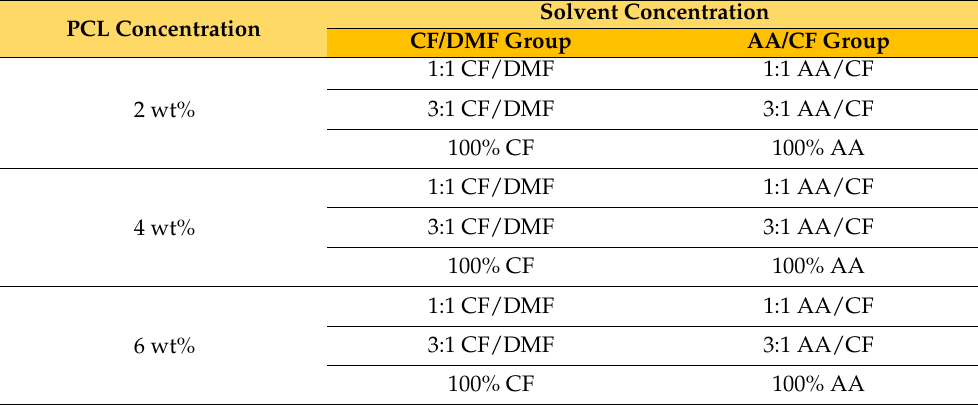
Table 1. Overall study design demonstrating the test groups and samples